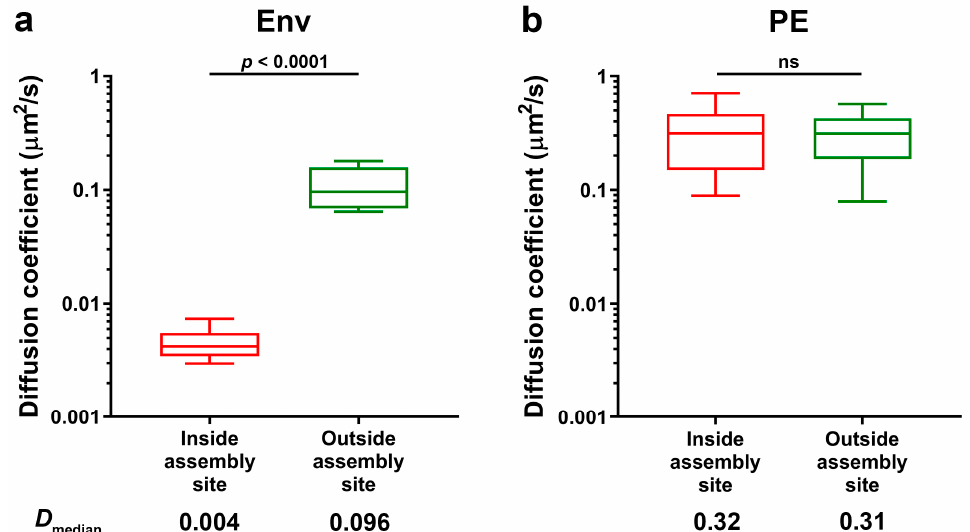
Figure 3. Env ( a ) and phosphatidylethanolamine (PE) ( b ) mobility inside and outside HIV-1 assembly sites of NL4.3 Gag.iGFP HIV-1 infected Jurkat T-cells. Median Env and phosphatidylethanolamine (PE) diffusion coefficients ( D a ) were determined by sSTED-FCS measurements of 20 sites each from two independent virus preparations and infections. Box and whisker plots (horizontal line—median, box—25–75% percentiles or interquartile range (IQR) and whiskers—10–90% measurements) showing D a values inside and outside assembly sites (red and green, respectively). Statistical significance was assessed by Wilcoxon rank-sum test.